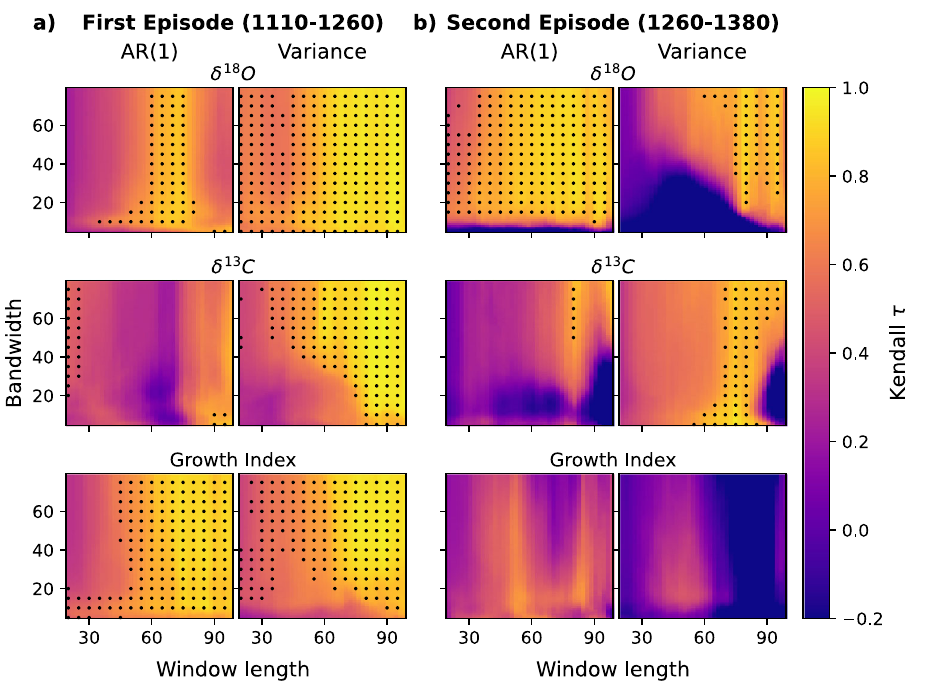
Fig. 3 | Robustness analysis of window length and detrending bandwidth choice. AR(1) and variancerobustness during the a fi rst and b second episodesfor δ 18Oshell (upper panels), δ 13Cshell (middle panels) and Growth Index (lower